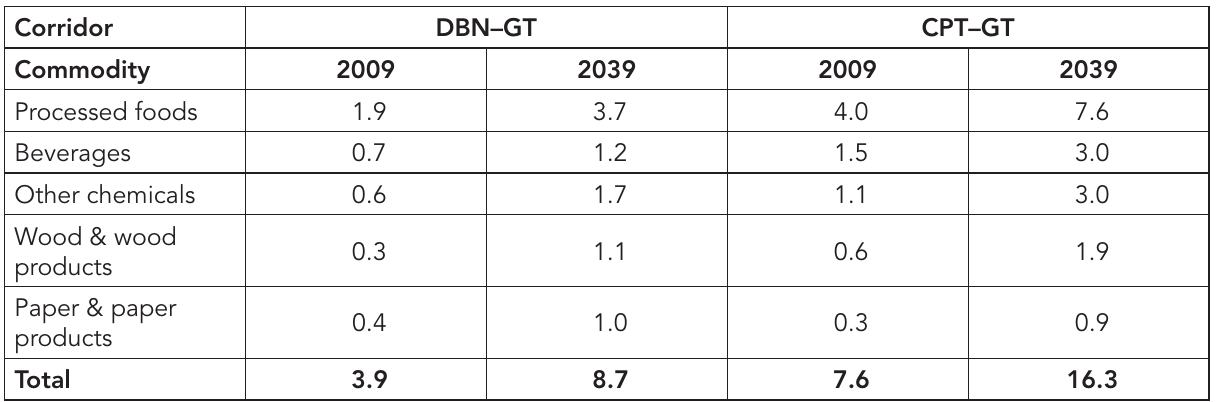
Table IV: Gains for rail transportation from key